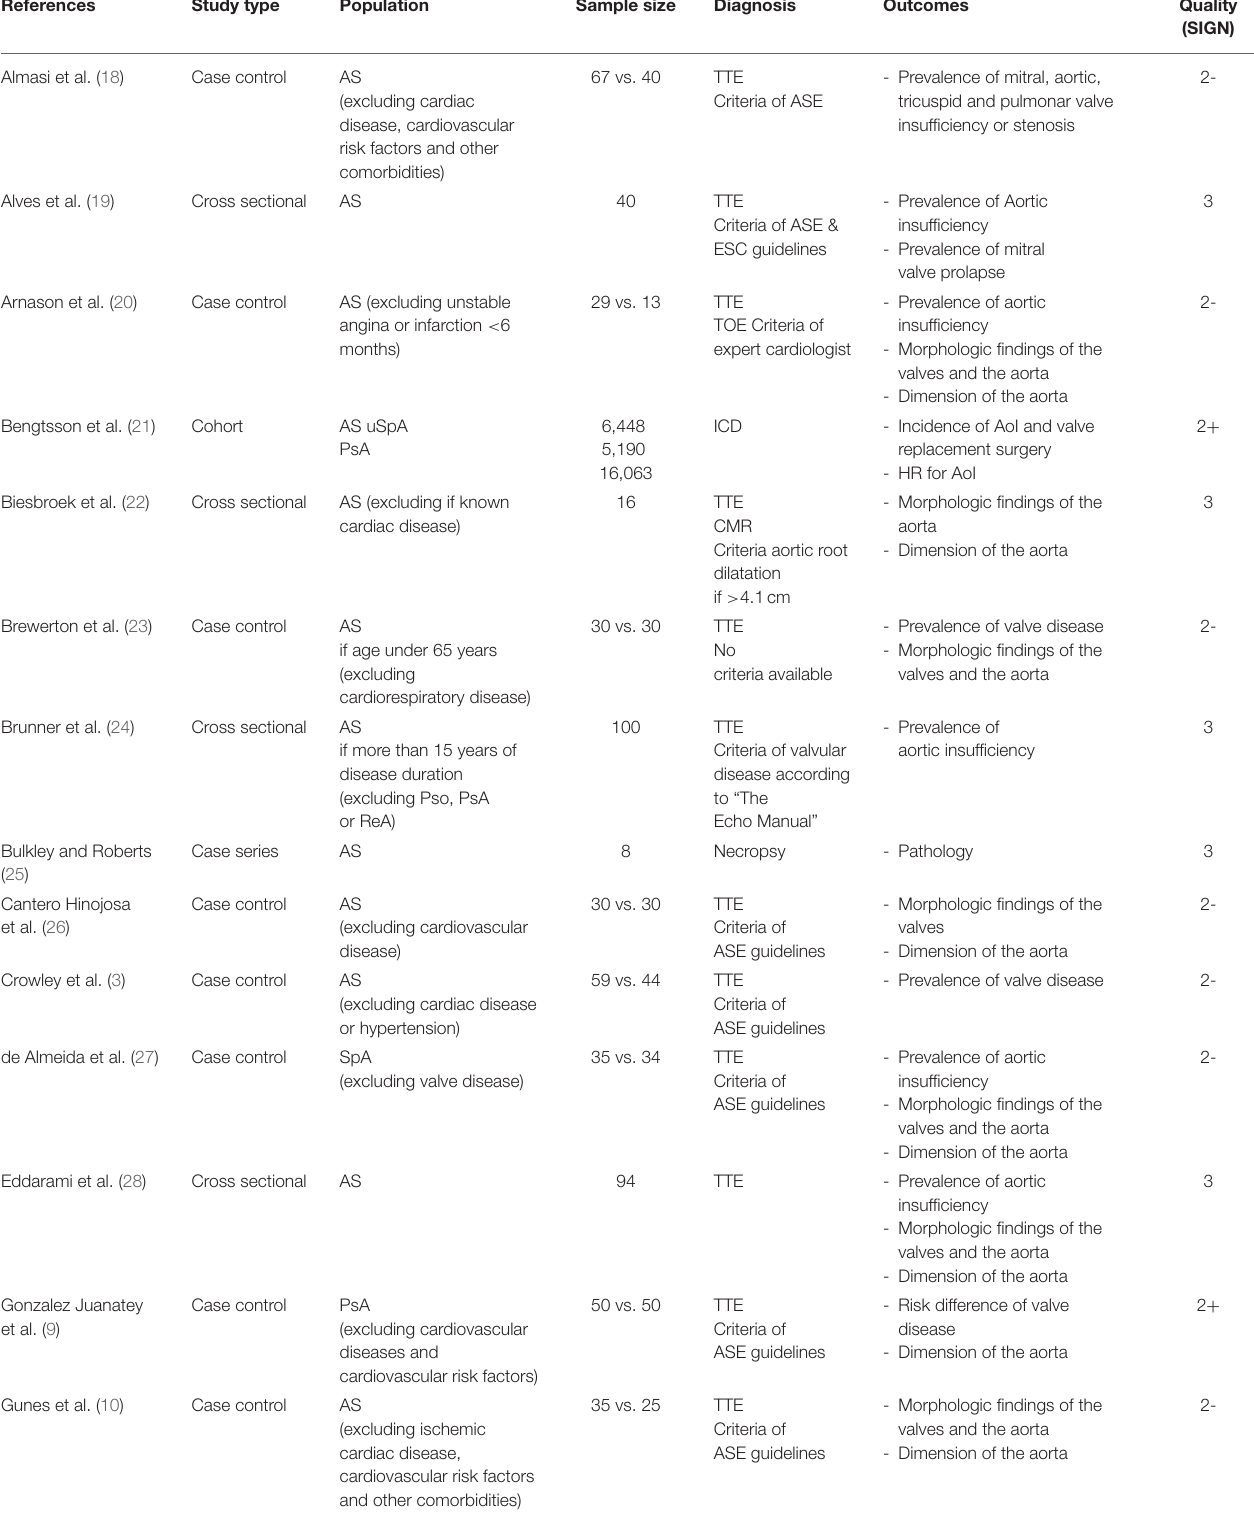
TABLE 1 | Characteristics of the studies included in the systematic literature